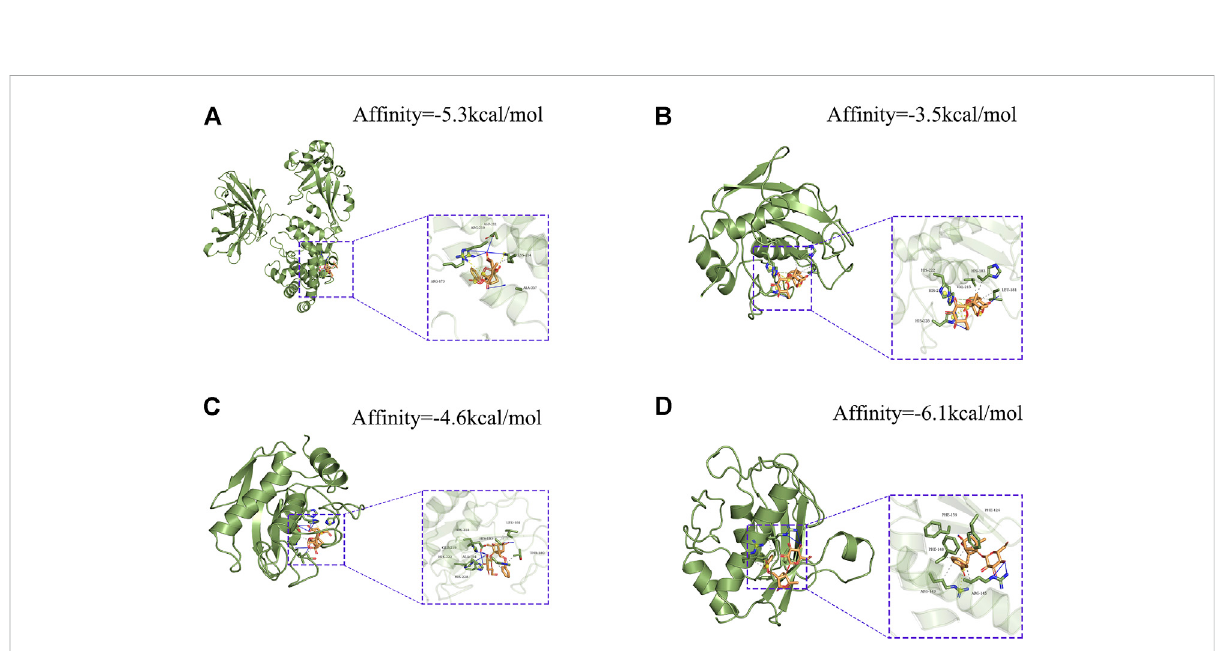
FIGURE 7 Molecular docking models of PF binding to potential targets. (A) HBEGF; (B) MMP1; (C) MMP7; (D)